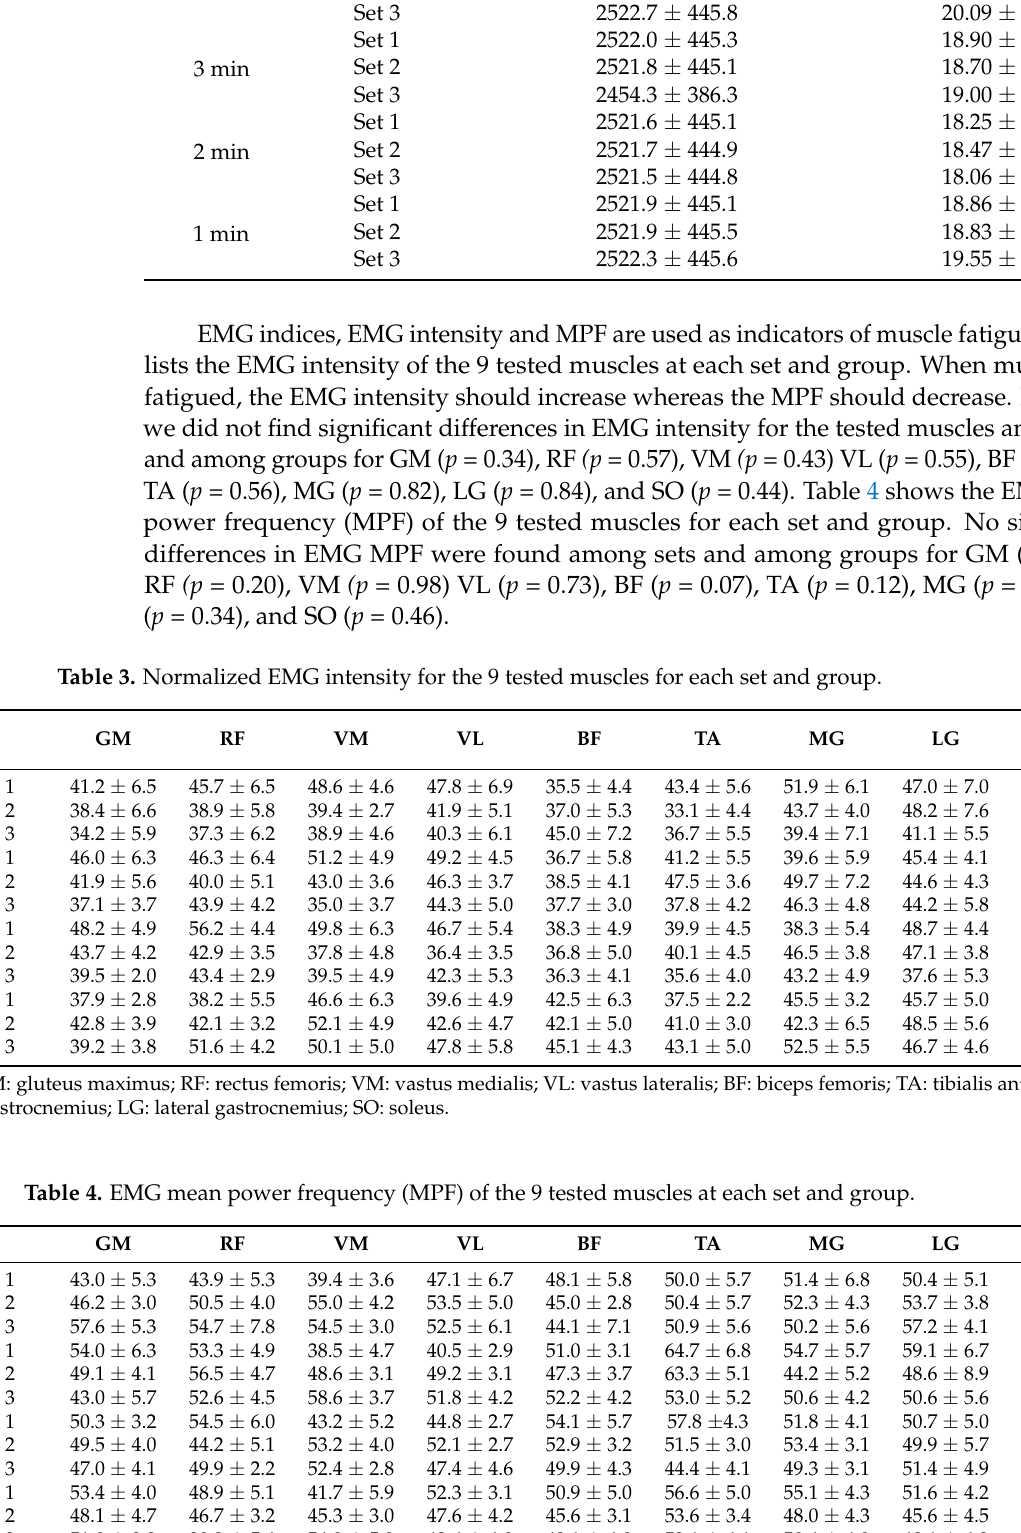
Table 2. Mean set values of the peak explosive power and jump height for the 4 groups.